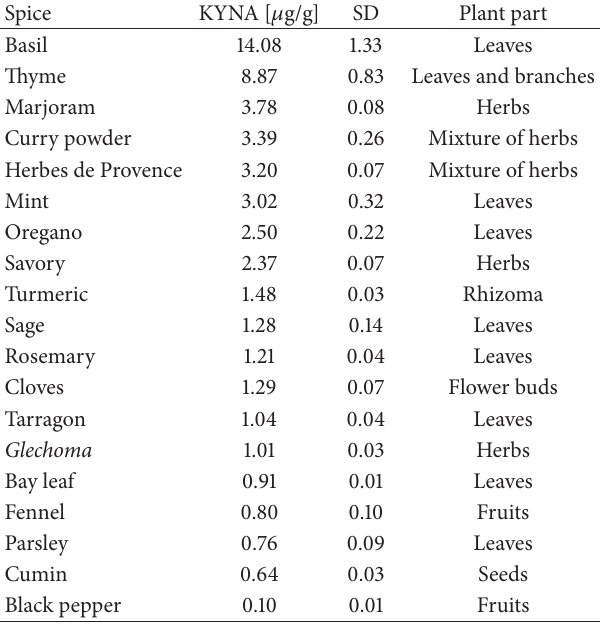
Table 1: KYNA content in analysed spices and